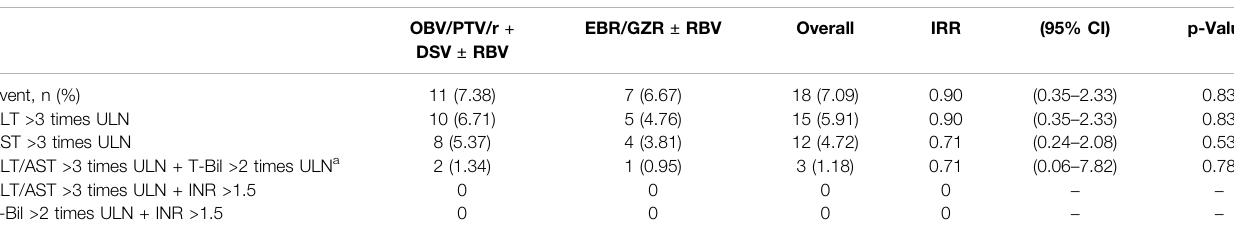
TABLE 4 | Sensitivity analysis — the change in the ALT/AST